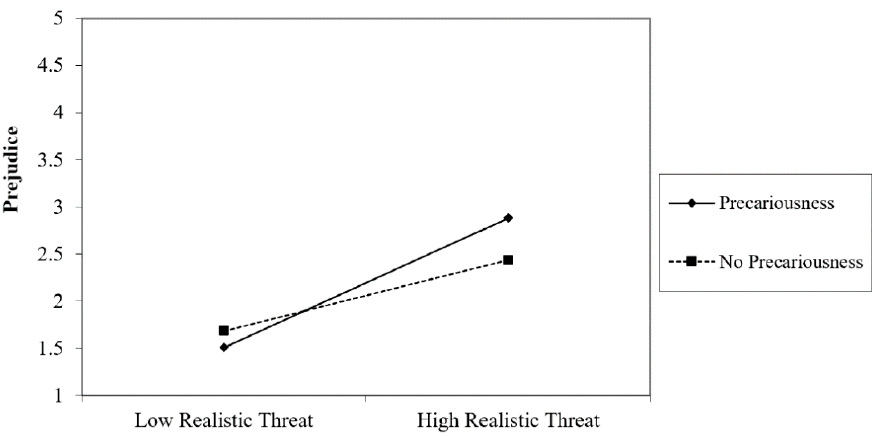
Figure 1. Interaction between Realistic Threat and Precariousness on